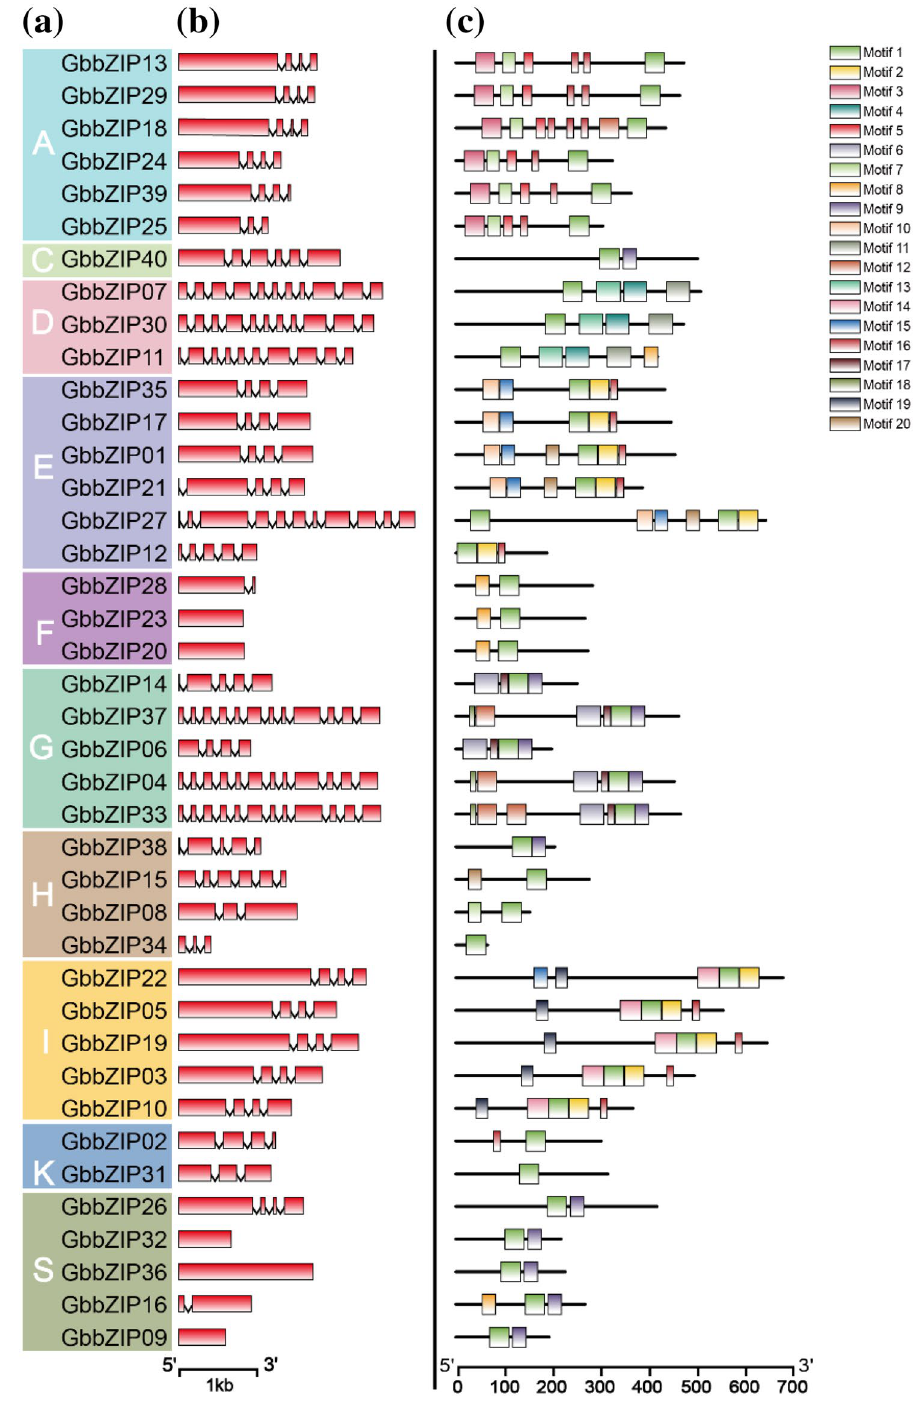
Figure 4. Characterization of GbbZIP genes in G. biloba . ( a ) The clustering of GbbZIP proteins based on Neighbor-Joining phylogenetic tree. ( b ) Exon–intron structures of GbbZIP genes were visualized with GSDS website (http:// gsds. gao- lab. org/). The red block represents the coding sequence (CDS), the broken line represents intron. ( c ) Distribution of conserved motifs for GbbZIP proteins was visualized with TBtools